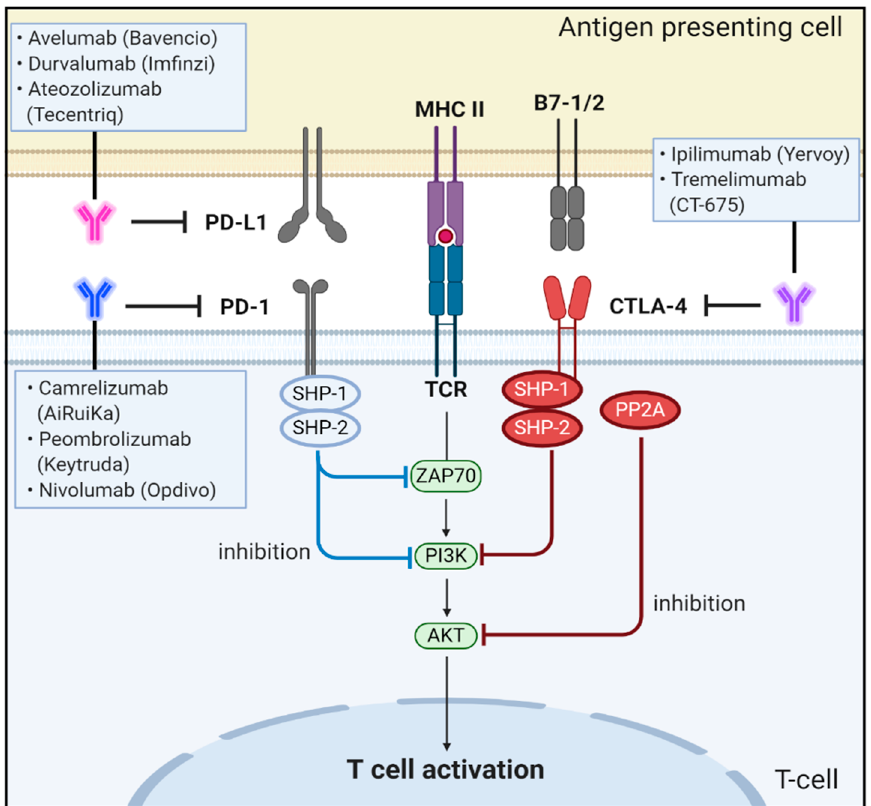
Figure 3. Schematic representation of the physiological roles and signaling pathways of immune checkpoint proteins of PD-1, PD-L1, CTLA-4, and B7-1/2 and effect of antibodies targeting these signaling molecules on CRC progression and metastasis.